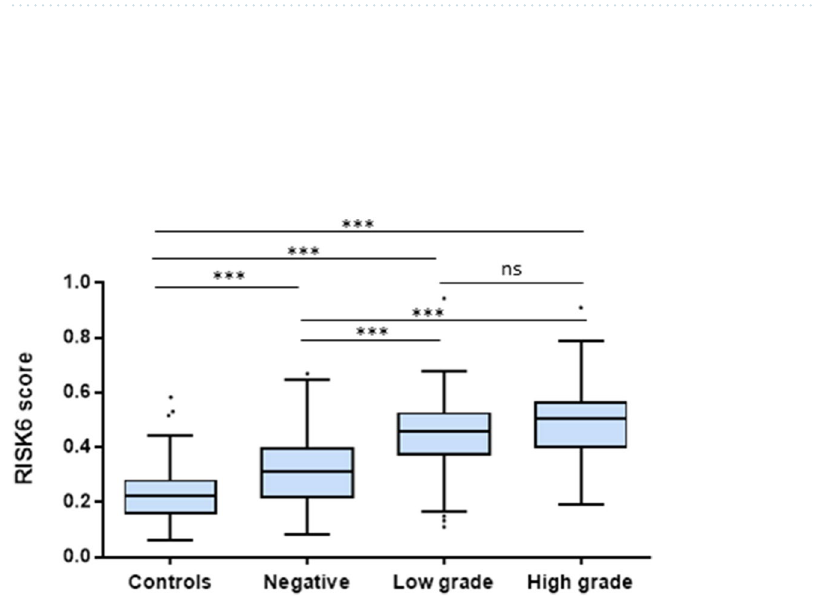
Figure 2. Correlation between RISK6 signature scores and mycobacterial loads determined by sputum smear microscopy in ATB patients. Boxplots comparing the RISK6 score levels stratified according to sputum smear grade: Negative smears, low grade positive smears (1+ or scanty) and high grade positive smears (2+ or 3+). Horizontal lines designate medians, boxes represent the inter-quartile ranges (IQR) and the ranges are represented by whiskers. Individual dots represent the results of patients with a RISK6 scores out of IQR. Statistical significance was calculated using Mann–Whitney U test. Ns non-significant, ***indicates a p-value < 0.001. HD Healthy